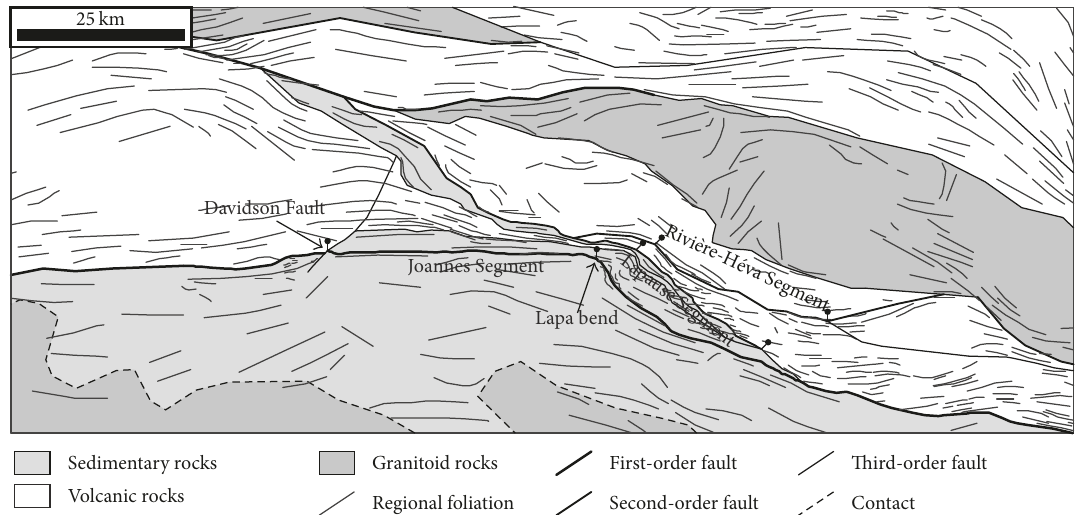
Figure 2: Schematic representation showing the distribution of rock types and the model geometry used in UDEC and failing fault